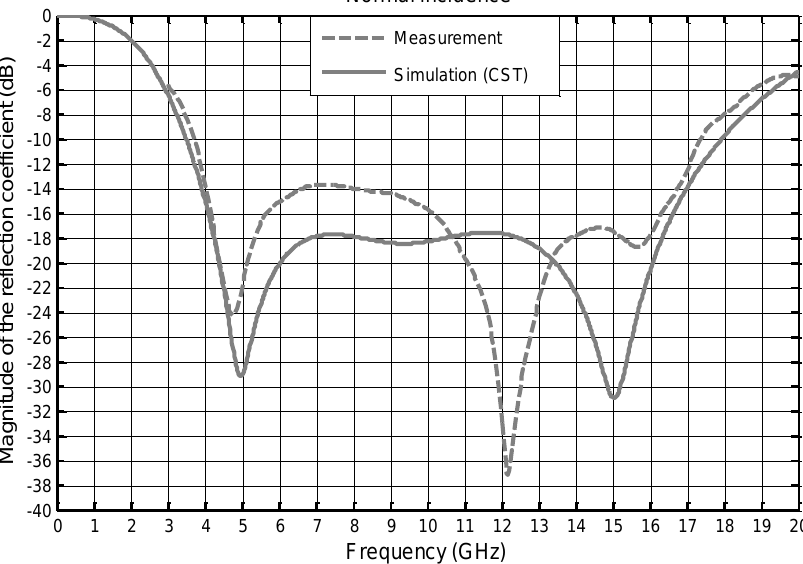
Figure 5. Comparison between the simulated and measured magnitudes of the reflection coefficient (dB) as a function of frequency at normal incidence.